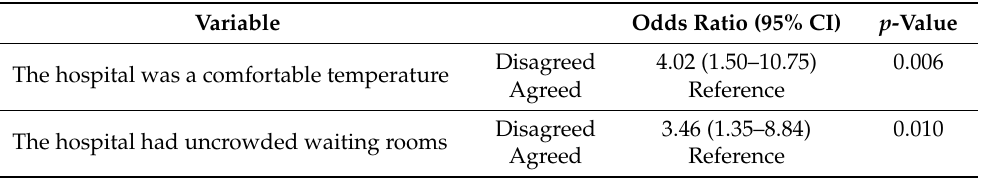
Table 5. Final logistic regression model of elements of the hospital that were associated with mood or wellbeing being affected by the treatment